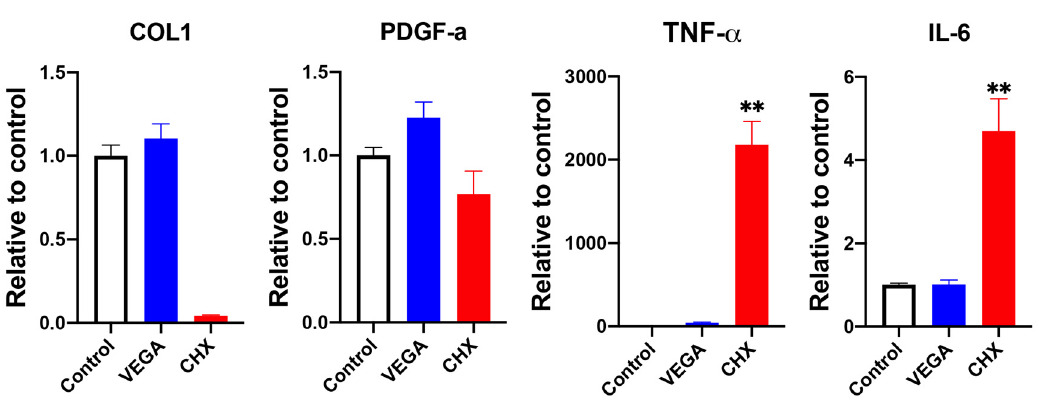
Figure 4. Real-time PCR of HGF-1 cells cultured in either 1% VEGA or CHX at 5 days displaying mRNA levels of COL1, PDGF-a, TNF- α , and IL-6 (n = 3, ** denotes significantly higher than all other treatment modalities, p < 0.05).